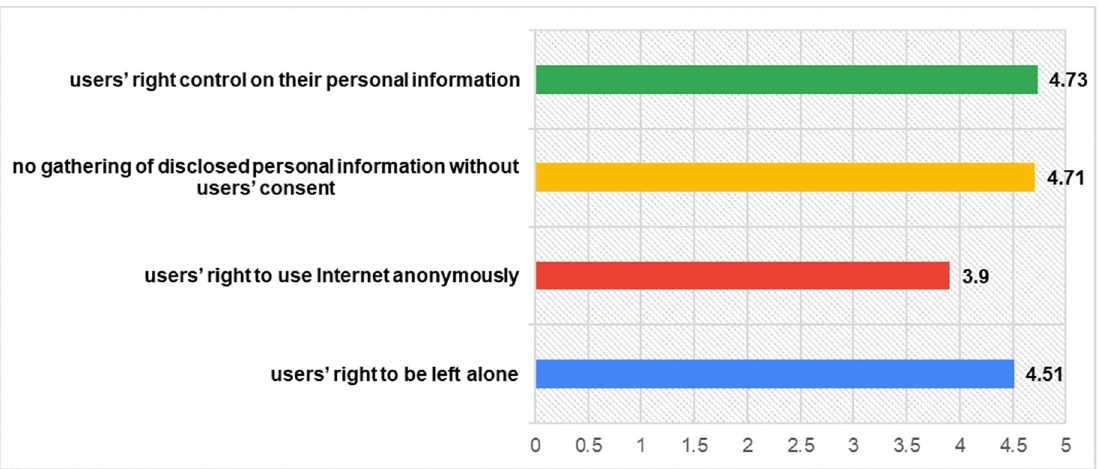
Figure 1. Beliefs in Privacy rights.